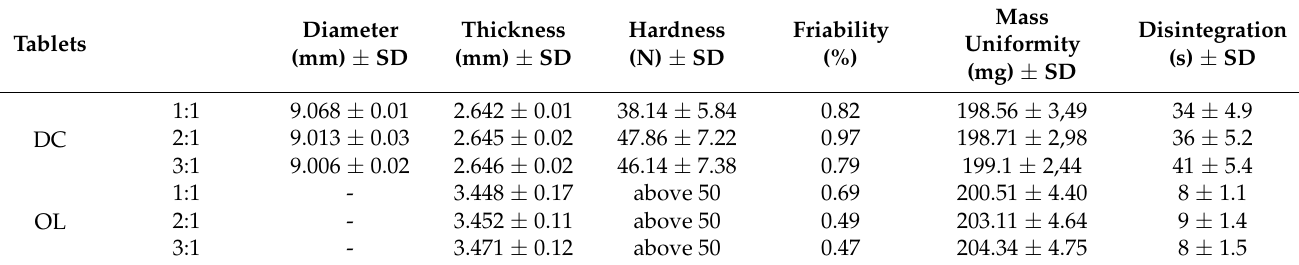
Table 3. Parameters of the ODx.